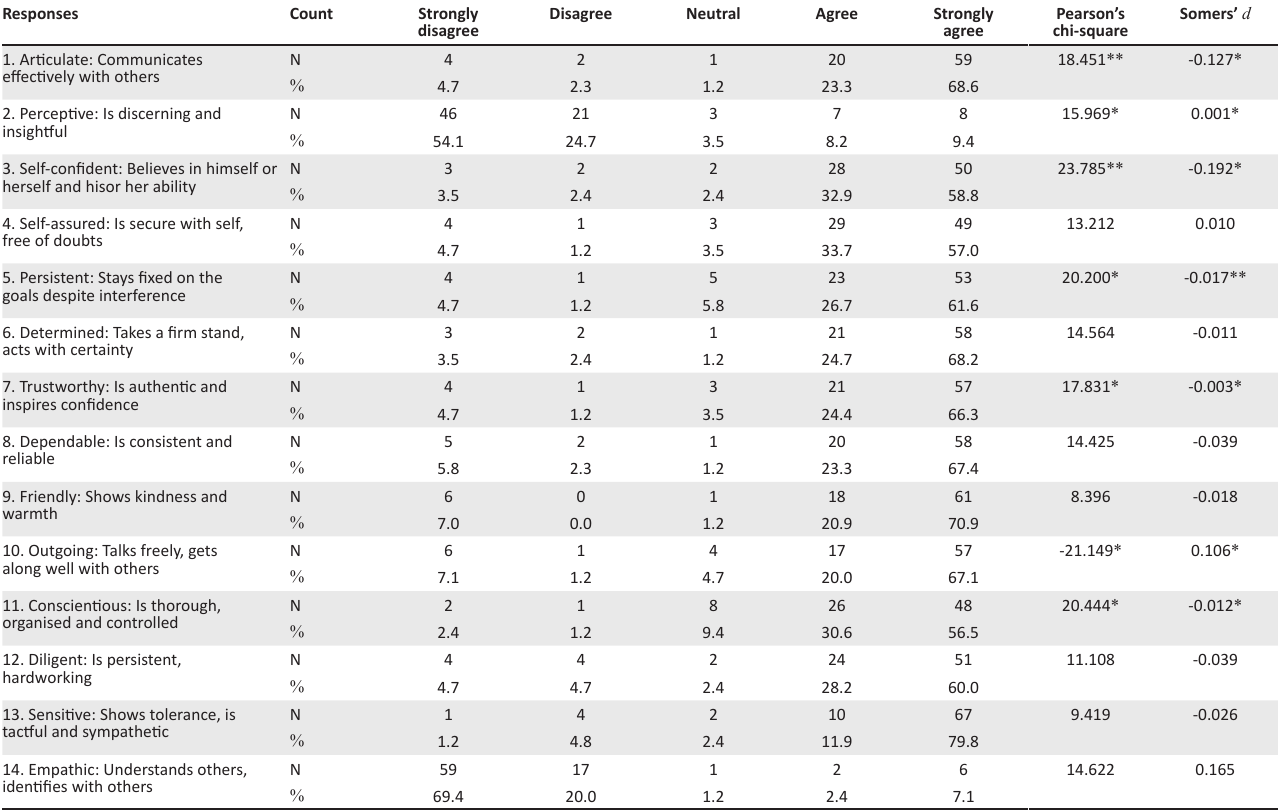
TABLE 1: Distribution of leadership characteristics responses and association with service delivery.